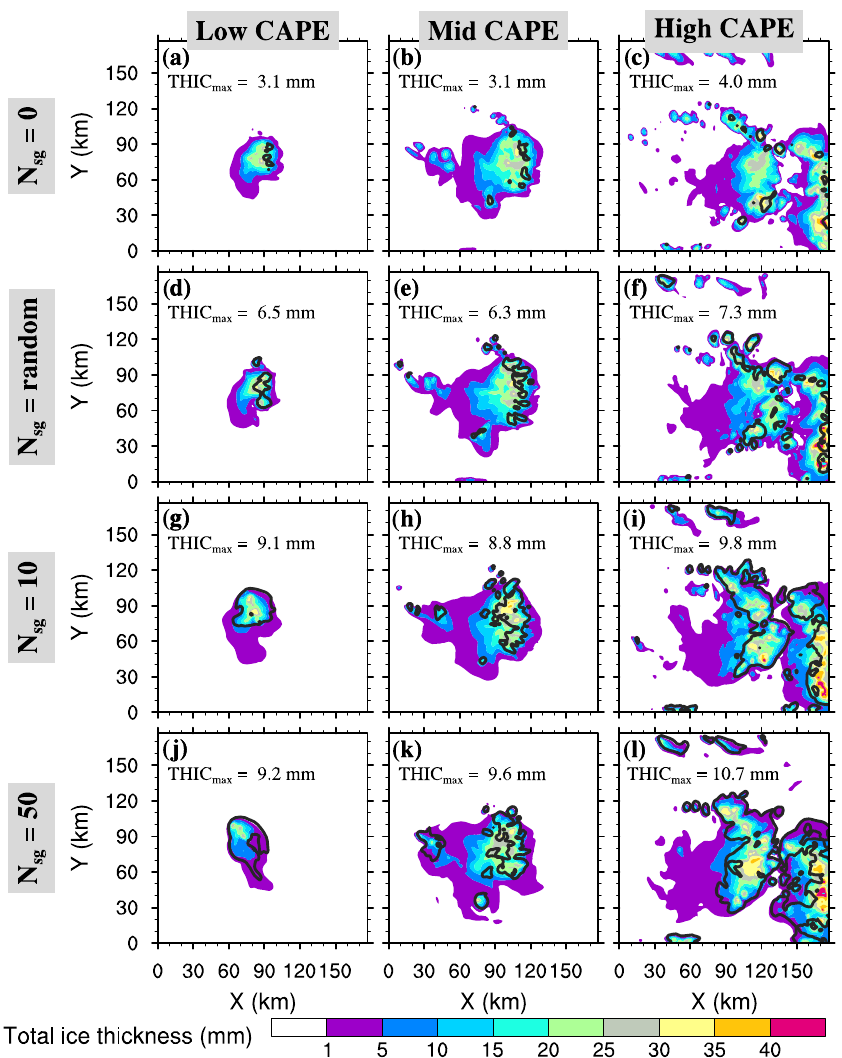
Figure 18. As in Fig. 16 but for the total ice thickness in millimetres after 4h of the WK84 simulations. The contours are the small ice thickness component (THIC) taken at 1mm. The peak value of THIC (THIC max ) is given in